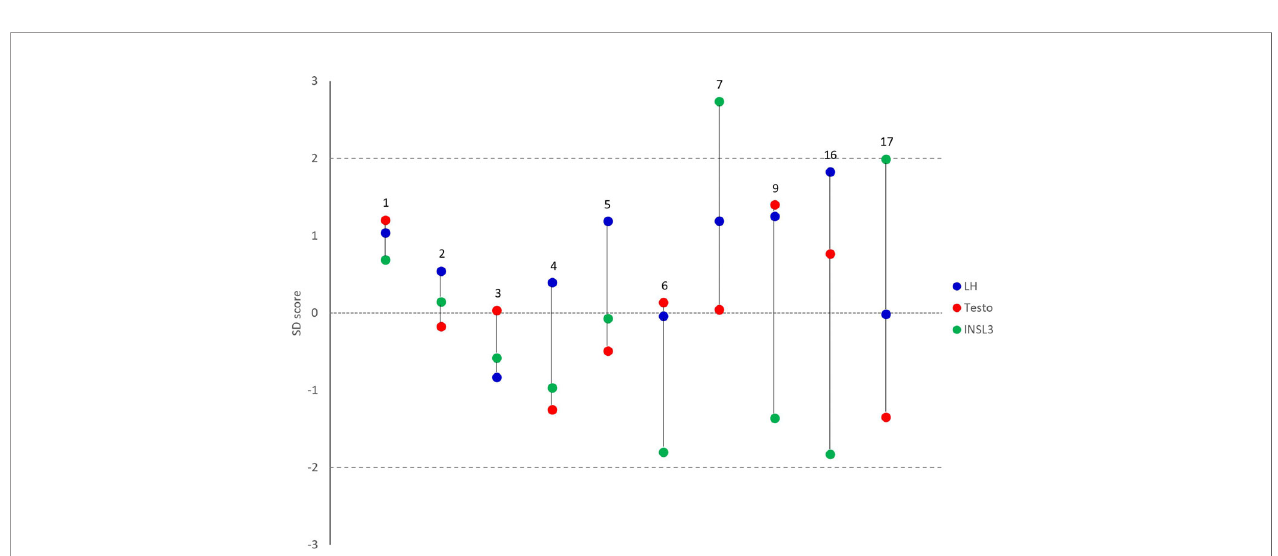
FIGURE 2 | Measurements of insulin-like factor 3 (green), Luteinizing hormone (blue), and testosterone (red) expressed as standard deviation (SD) scores in untreated male patients with 45,X/46,XY mosaicism. Numbers indicate IDs corresponding to numbers in Tables 1 , 2 . Dashed lines represent +/-2 SD scores, while the dotted line represents the mean.